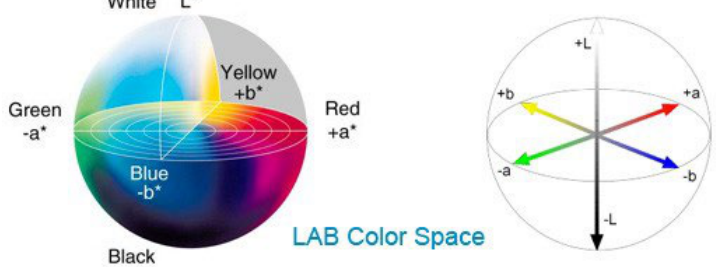
Figure 1. CIELAB color space (Adapted from